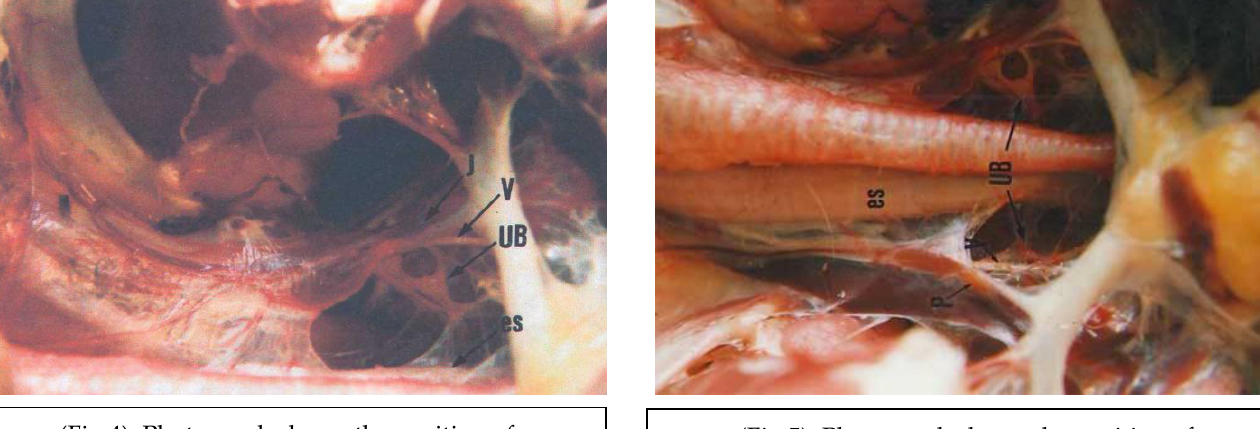
(Fig.5): Photogragh shows the position of ultimobranchial gland in young geese. Left ultimobranchial (LUB); Right ultimobranchial (RUB); Parathyroid (P); Common carotid artery;(CCa).